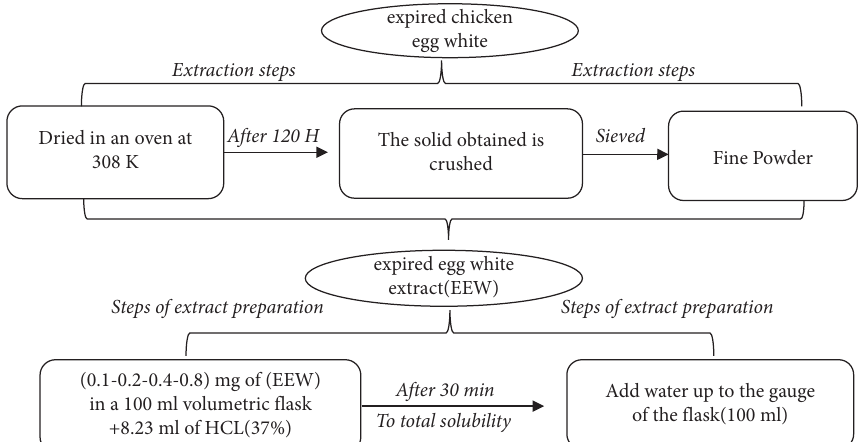
Figure 1: Extraction flowchart of